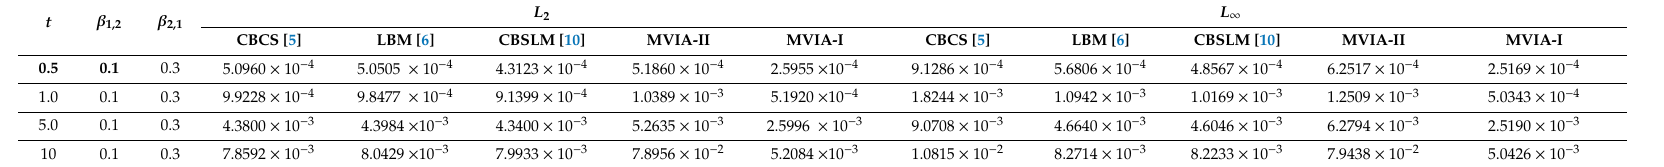
Table 2. Comparison of numerical results for v for di ff erent values of t and x for Test Problem 1.